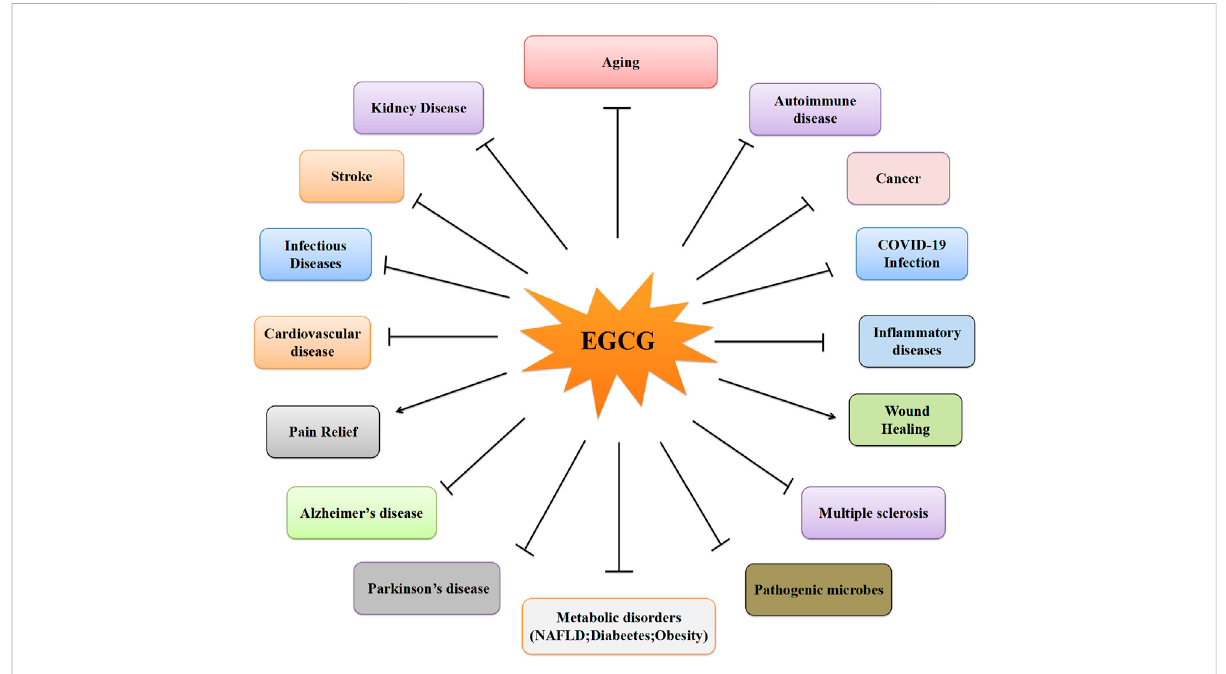
FIGURE 2 The different effects of EGCG on the different